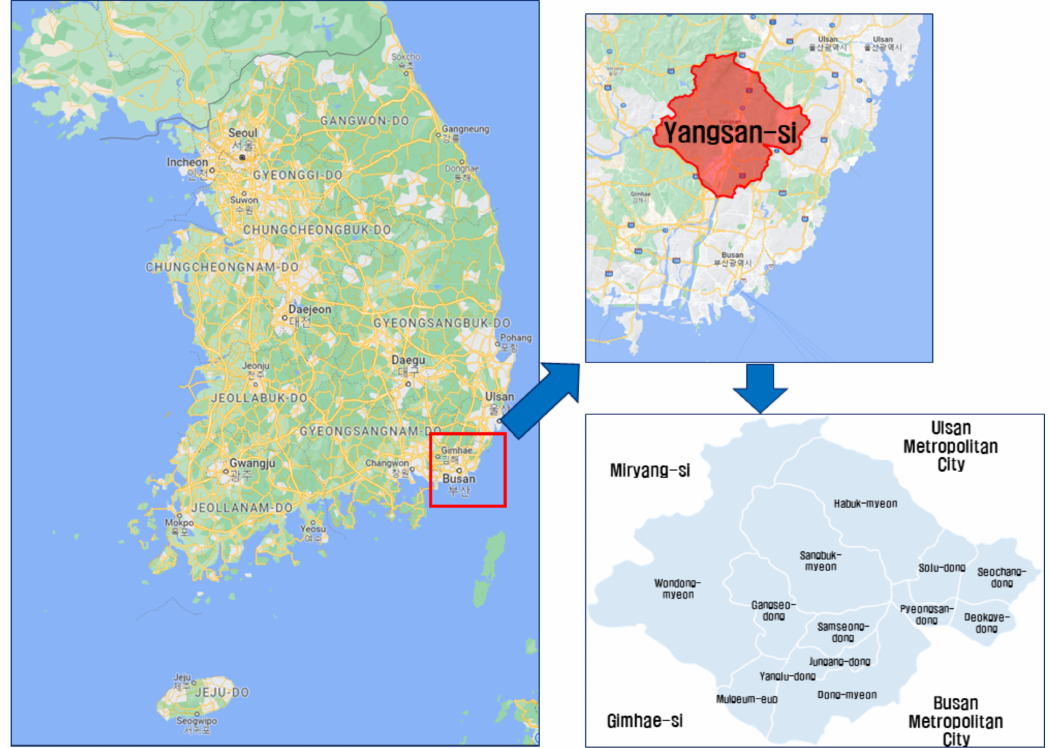
Figure 3. Location and administrative district diagrams of